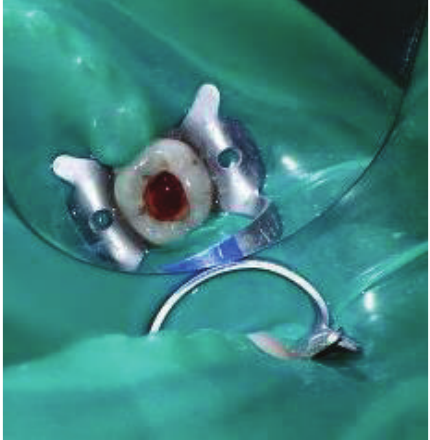
Figure 33: Access opening for pulpotomy procedure 36.